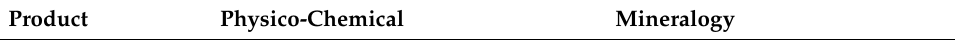
Table 12. The characteristics of tails of the final